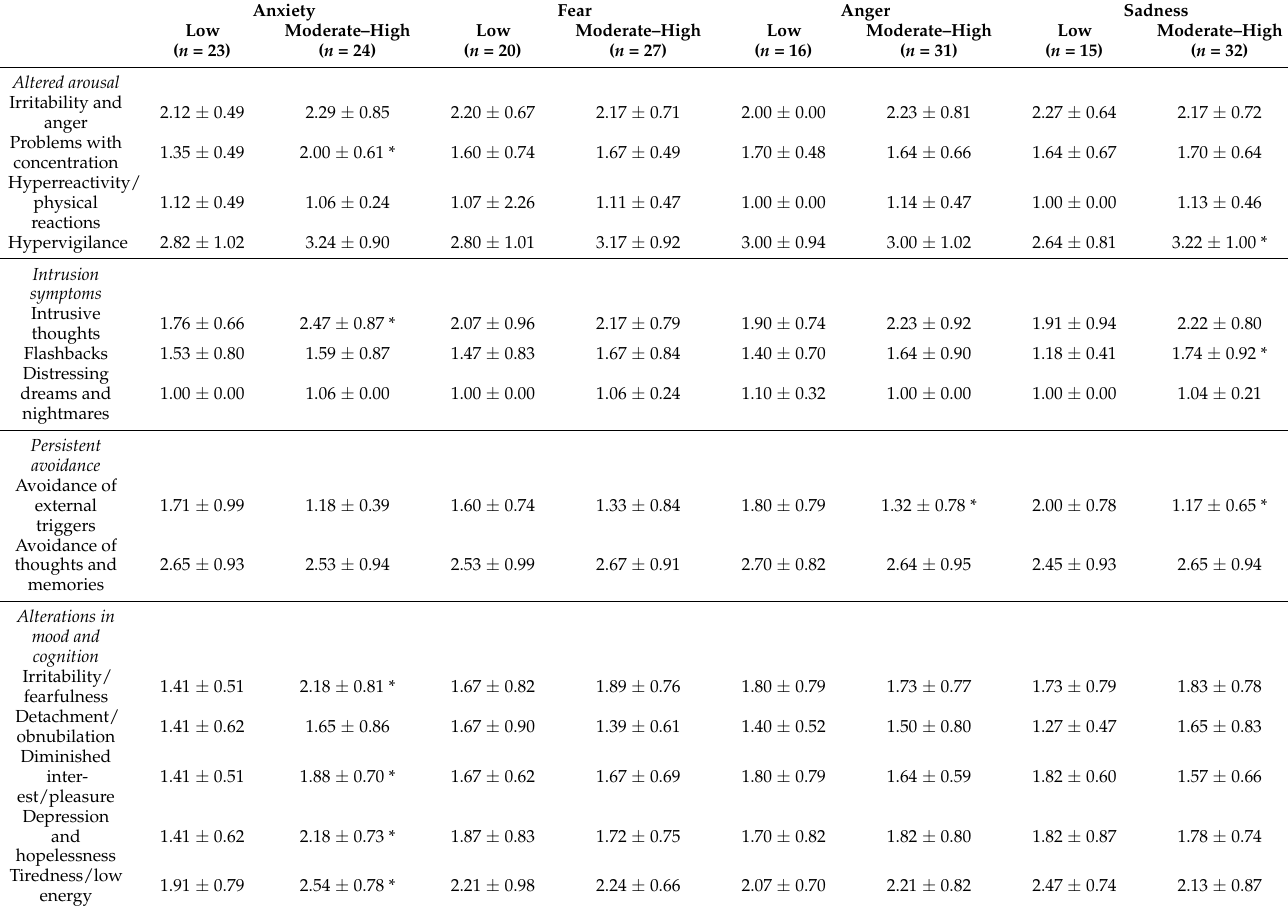
Table 5. Associations among emotional states and stress